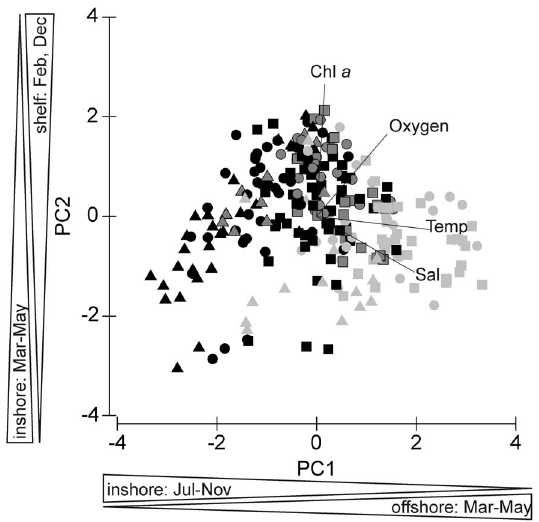
Figure 3. Inshore (triangles), shelf (circles) and offshore (squares) stations arranged according to the first two principal components. For a better overview, upwelling months (June- November) are black, while quiescent months (February to April) are light grey. Data of May and December are marked in dark grey, since these months showed a distinct oceanographic regime compared to the other months (start and end of upwelling period).